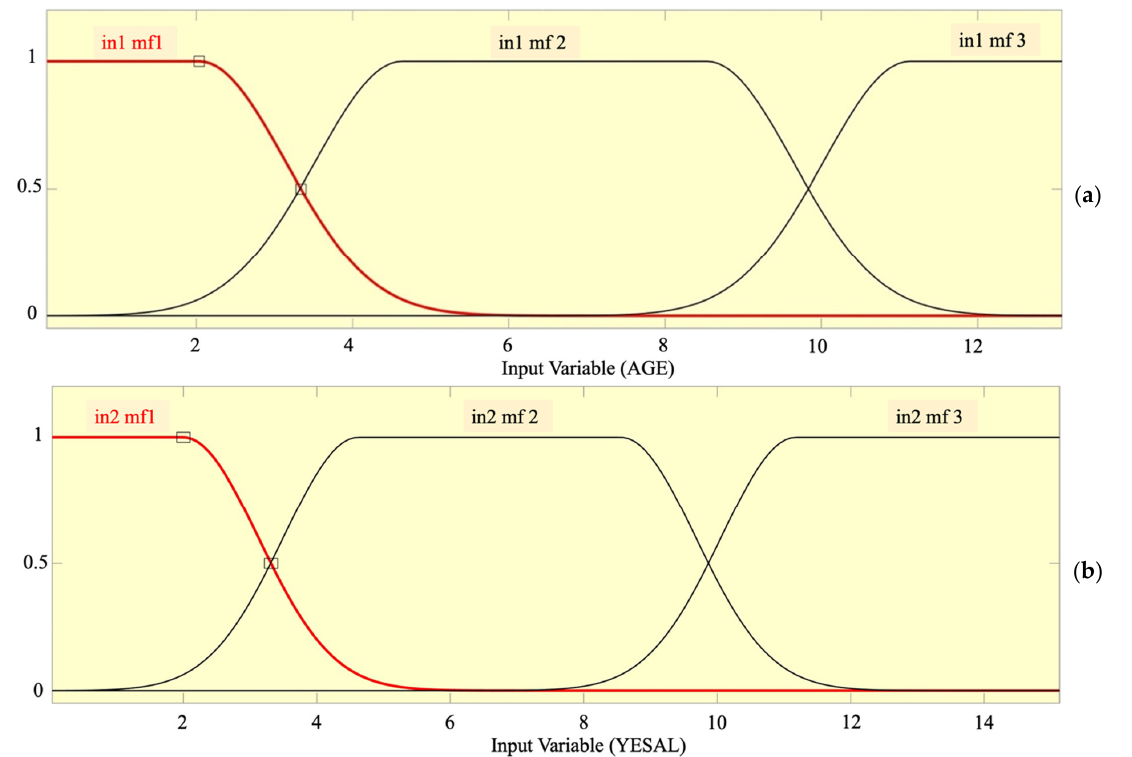
Figure 9. Initial MFs for AC input variables of ( a ) AGE and ( b ) YESAL.